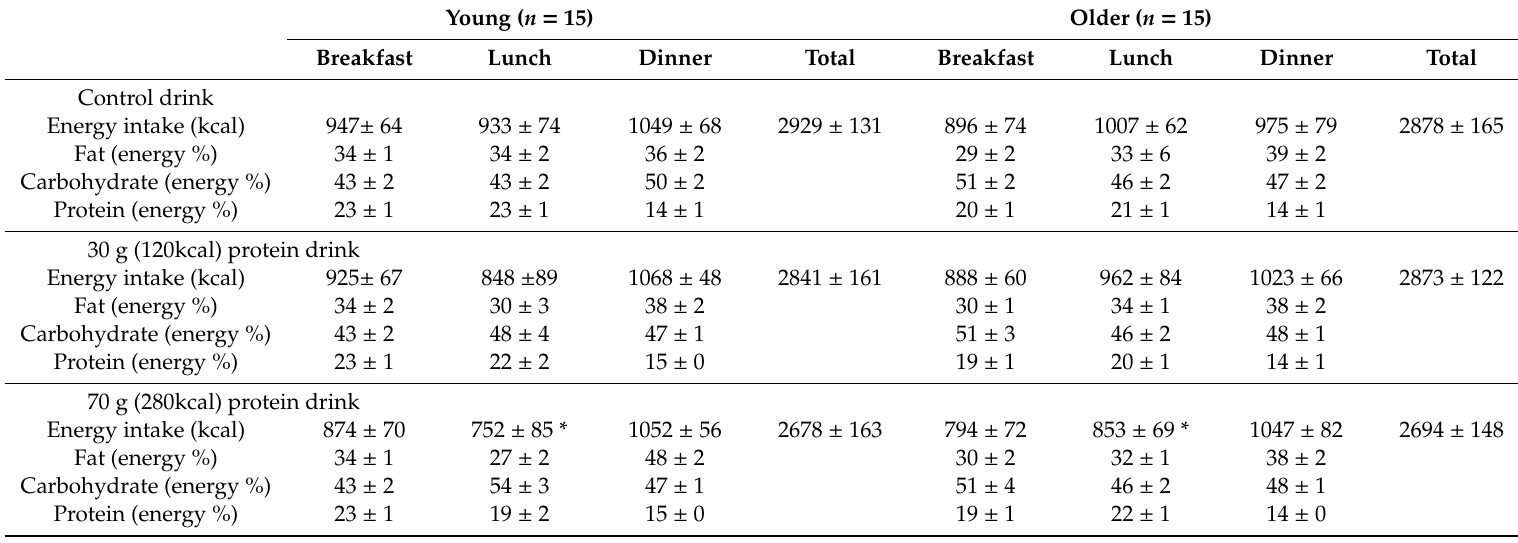
Table 3. Energy intake at and macronutrient composition of breakfast, lunch, and dinner following whey protein drink ingestion in healthy young and older men. Young ( n = 15) Older ( n = 15) Breakfast Lunch Dinner Total Breakfast Lunch Dinner